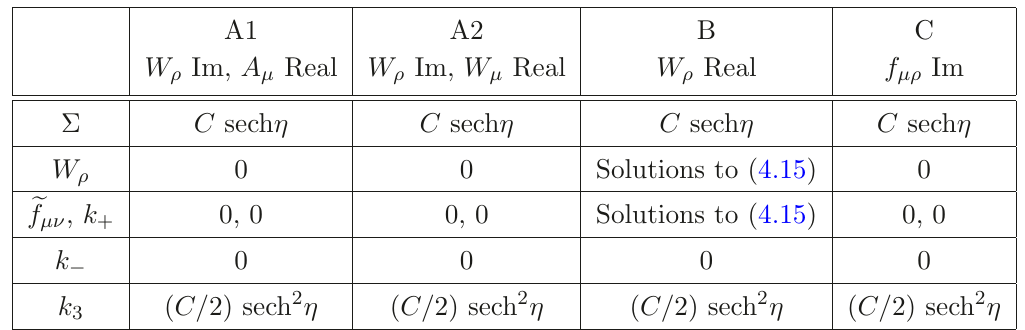
Table 3 . The complete set of off-shell BPS solutions for vector multiplet fluctuations around the near-horizon static black hole for different reality conditions. Here f MN is the fluctuation of the field strength of W M , f µν is the fluctuation of the field strength of A µ , Σ is the fluctuation of the scalar σ , and k ± , k 3 are the fluctuations of the auxiliary fields Y ij . For condition B, some explicit e solutions to equations (4.15) are presented in